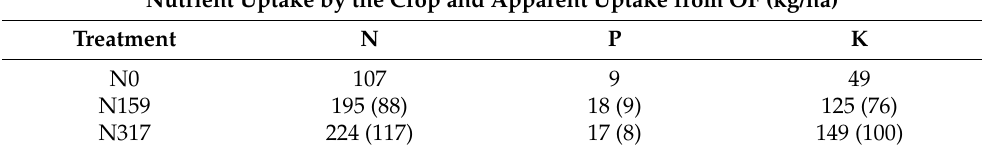
Table 6. Nutrient uptake by the yield of Chinese cabbage and apparent uptake from OF (in brackets) in kg/ha.